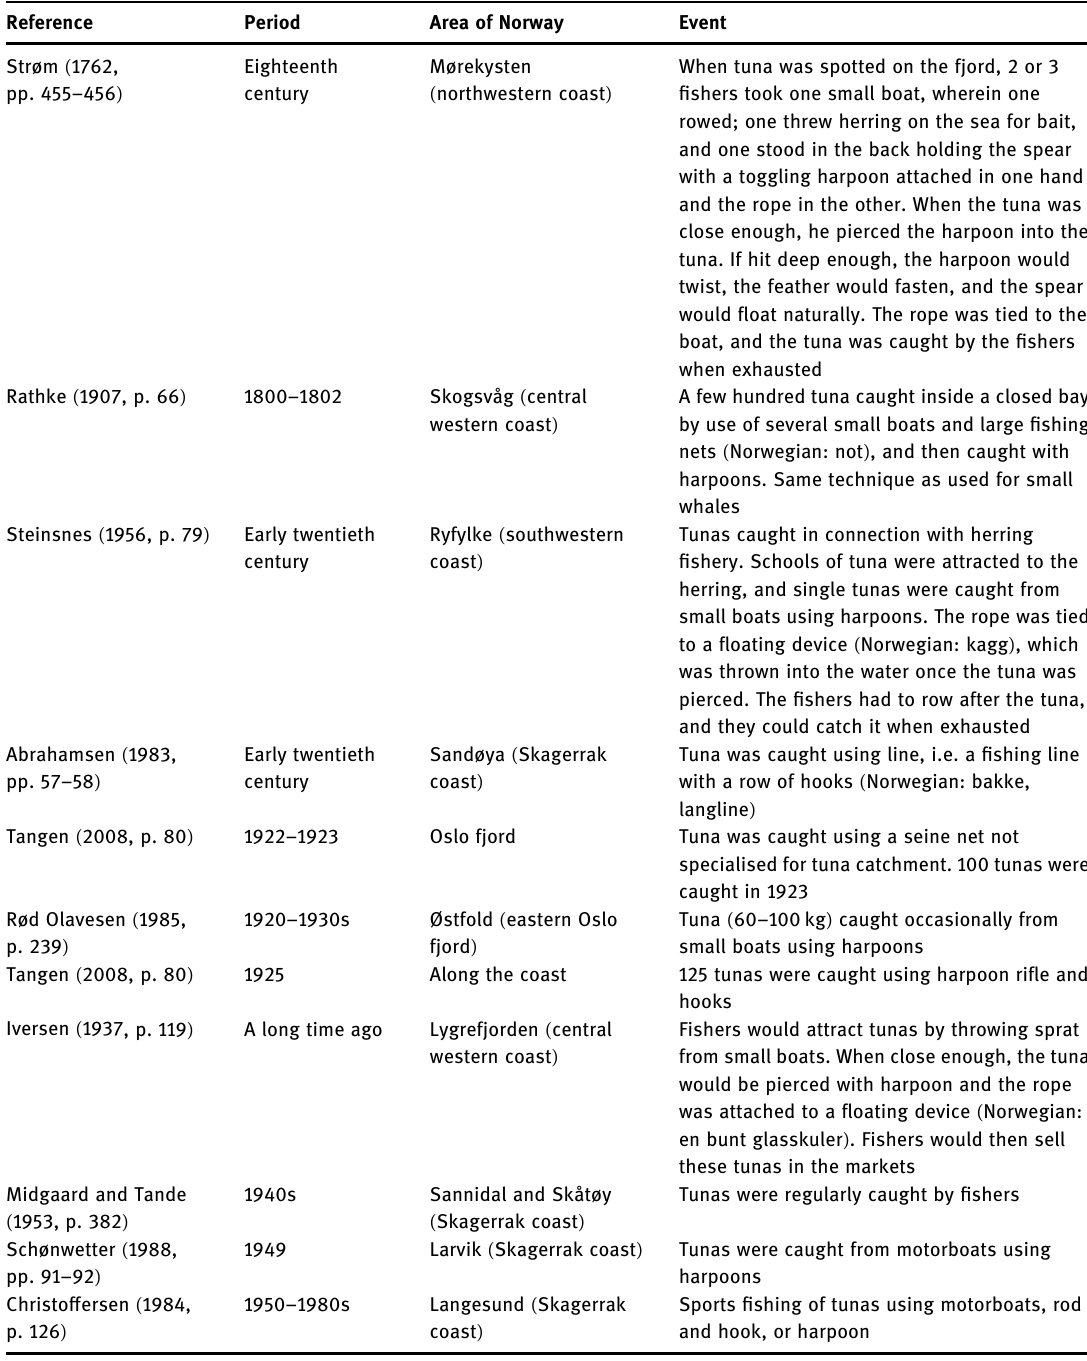
Table 3: References to eighteenth to twenty - fi rst century coast near fi shing events of Blue fi n tuna in Norway